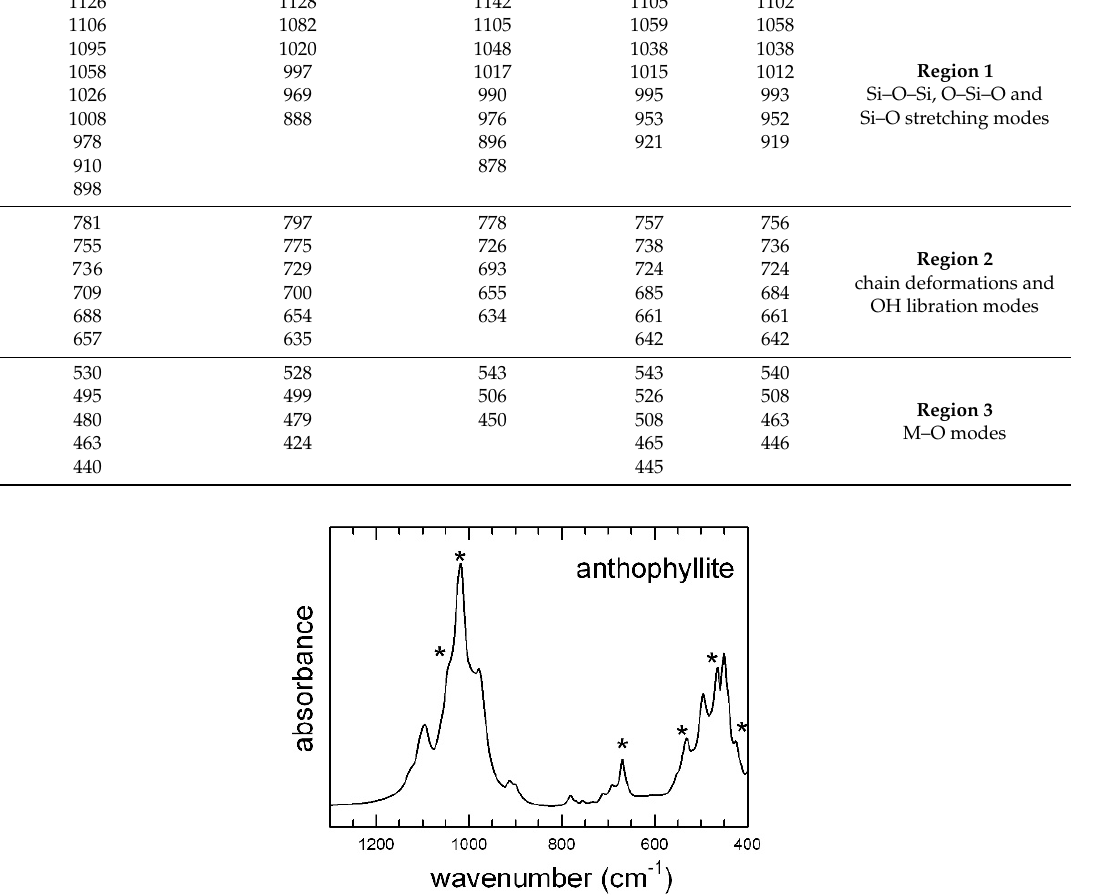
Table 4. Peak positions (cm − 1 ) and band assignment (according to 71) for the studied amphiboles in the low-wavenumber (<1200 cm − 1 ) range.